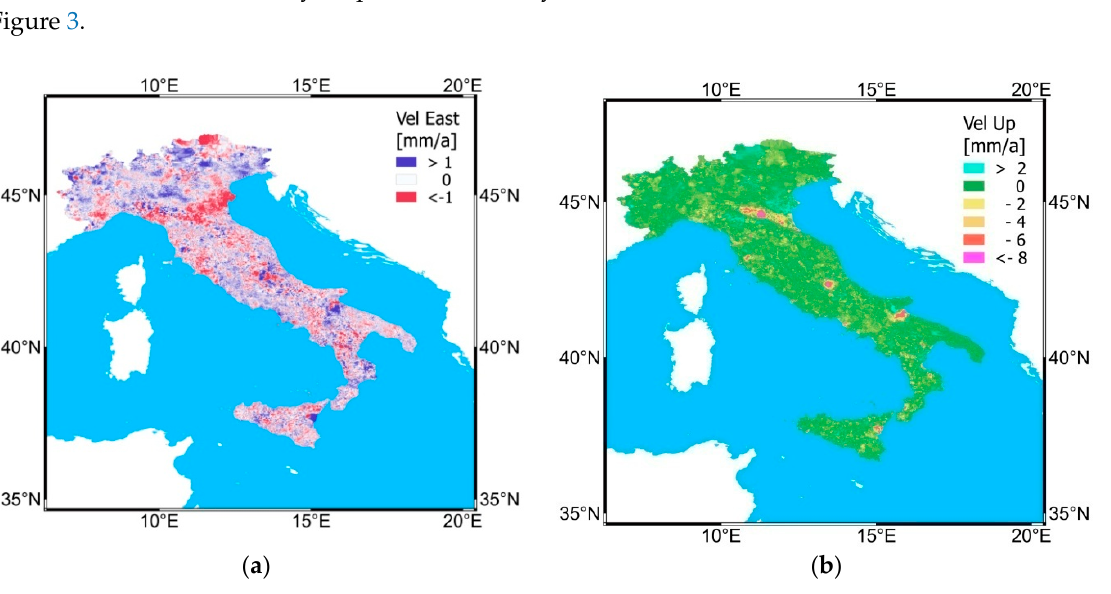
Figure 4. Comparison of the GNSS and SAR velocity components (vertical— a , East— b ) calculated for each of 621 GNSS sites. The SAR velocities were calculated by applying exponential inverse distance weighting [41,42] to a cloud of points 1000 m from each GNSS site. The blue lines represent the Pearson correlation between the two techniques. The Pearson correlation coefficient is 0.19 for the vertical component (top-left) and 0.028 for the east component (top-right).